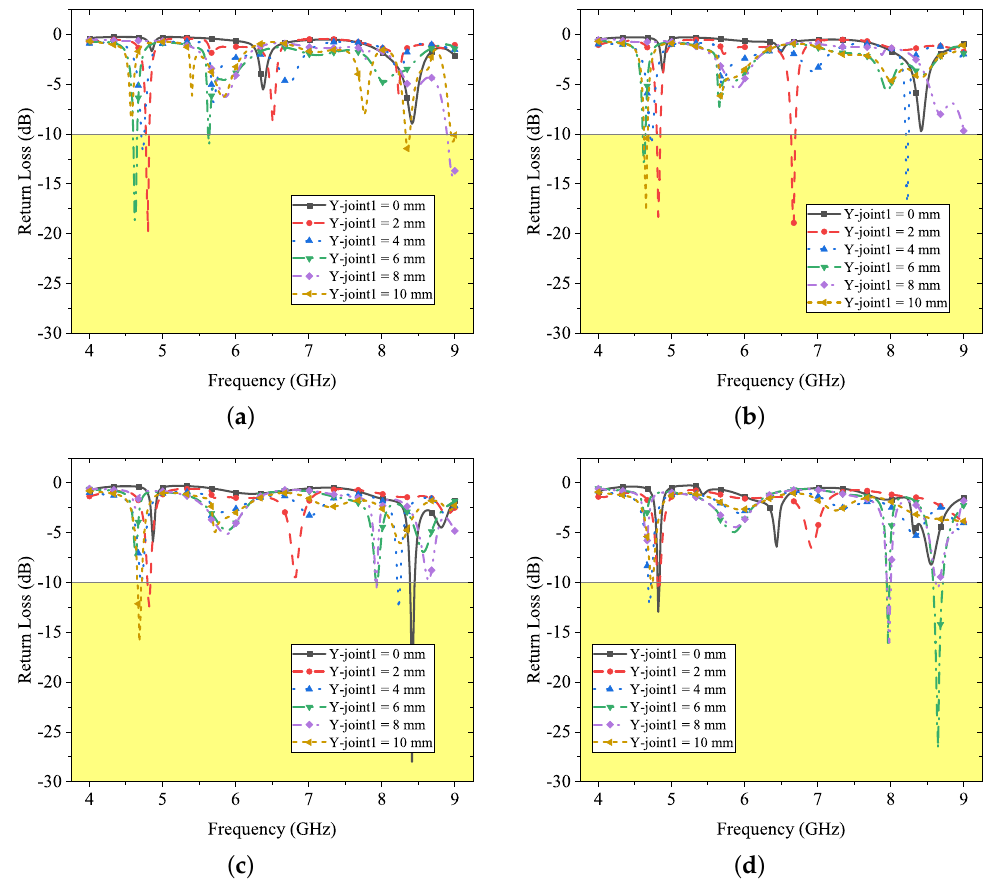
Figure 3. Effect of the joint1 position ( Y joint 1 ) on the return loss performance. ( a ) Parametric sweep when L joint 1 = 1 mm; ( b ) Parametric sweep when L joint 1 = 2 mm; ( c ) Parametric sweep when L joint 1 = 3 mm; and ( d ) Parametric sweep when L joint 1 = 4